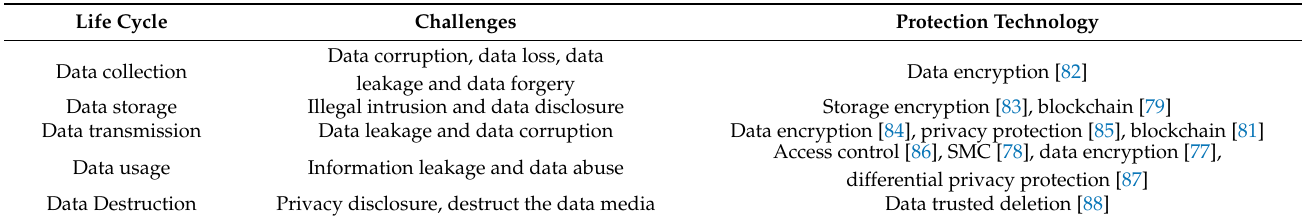
Table 2. Analysis of data security protection technology in the whole life cycle of food data. Life